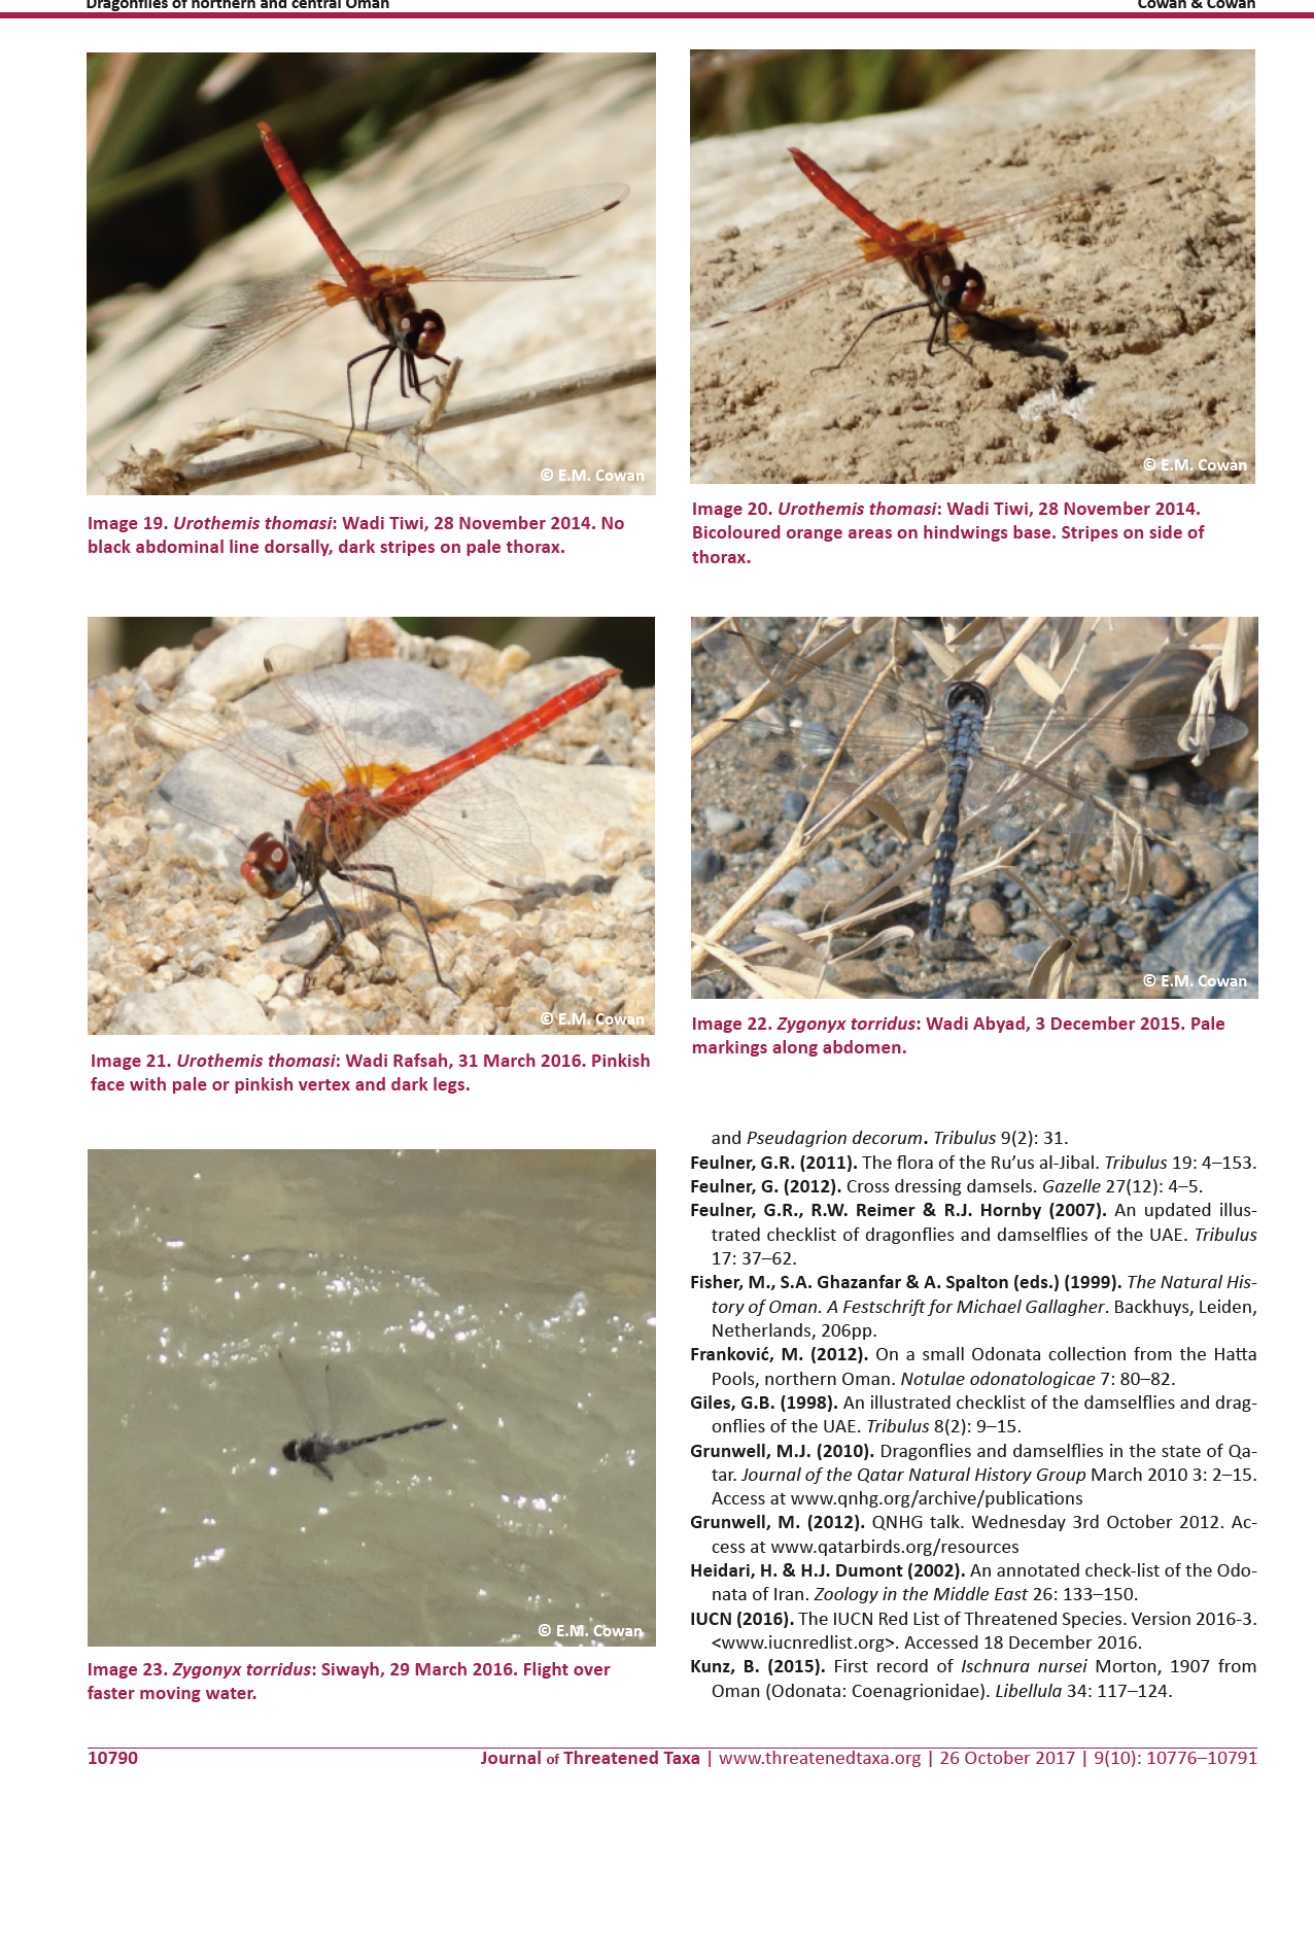
Image 23. Zygonyx ftorrfidus: Sfiwayh, 29 March 2016. Fflfighft over fasfter movfing